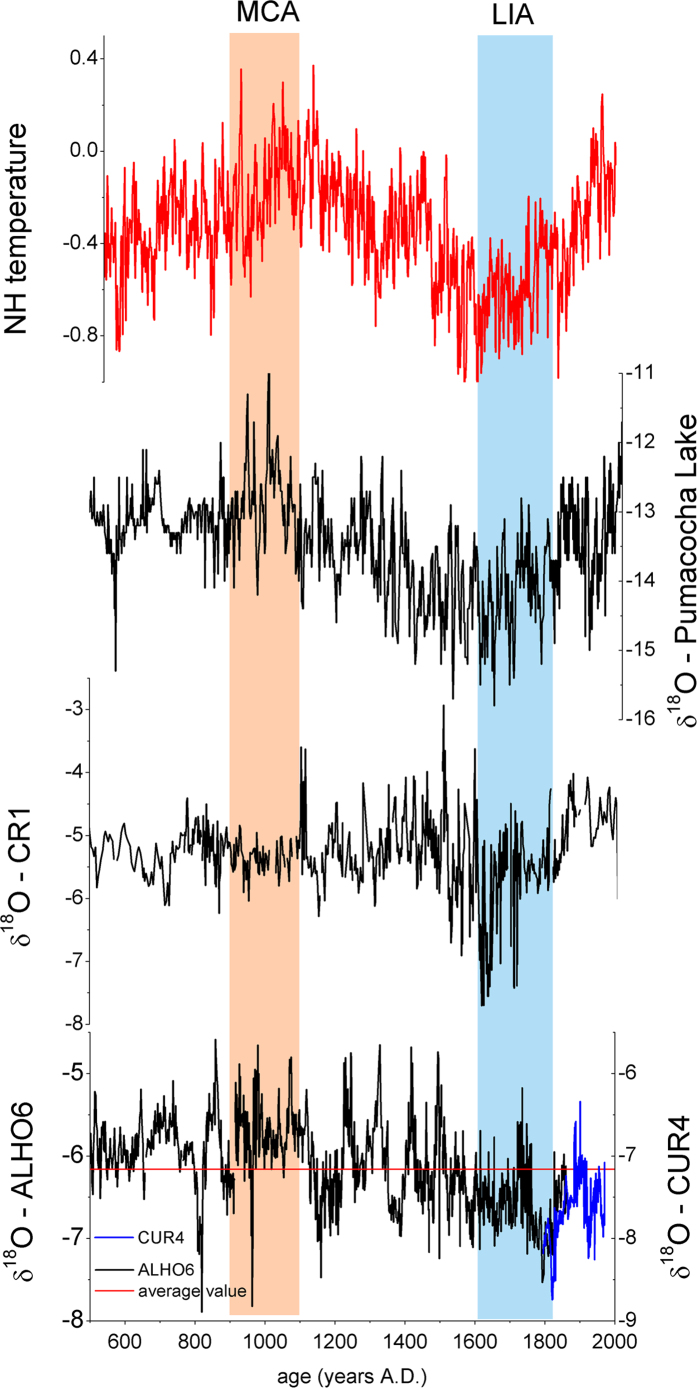
Comparison between the reconstruction of NH temperature41 with the δ18O records from Laguna Pumacocha19 located in the Peruvian Andes, CR1 stalagmite18 located in SE Brazil and our ALHO6+CUR4 record.